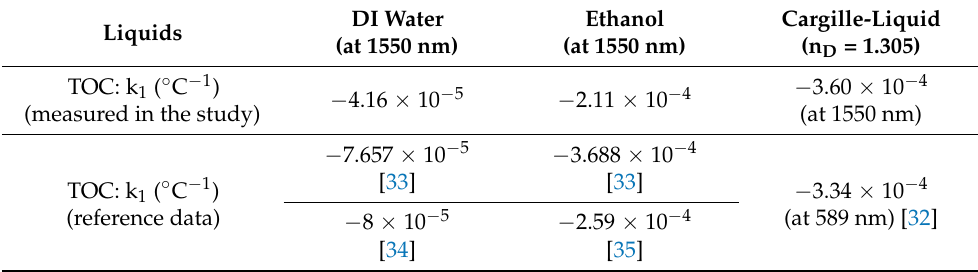
Table 1. Comparisons of the TOCs for three types of liquids between the experimental results proposed by this study and that of the reference